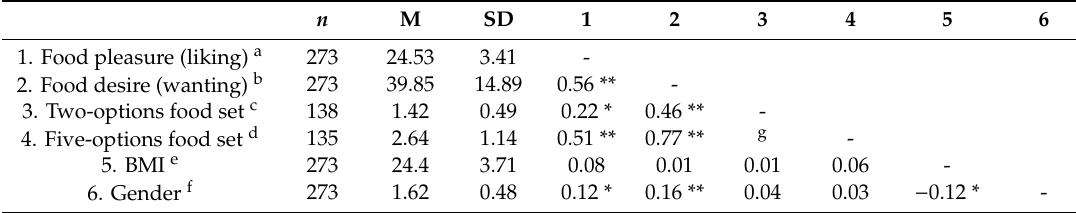
Table 2. Descriptive statistics and correlations among the variables.